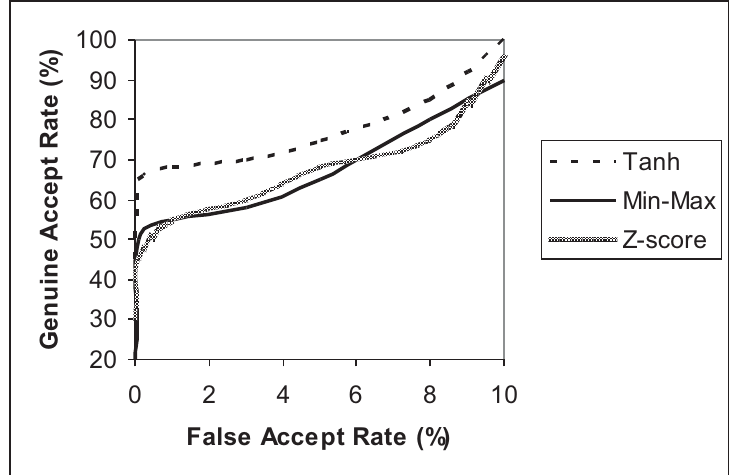
Figure 2. ROC curves showing the performance of each of the three normalization techniques on the Iris